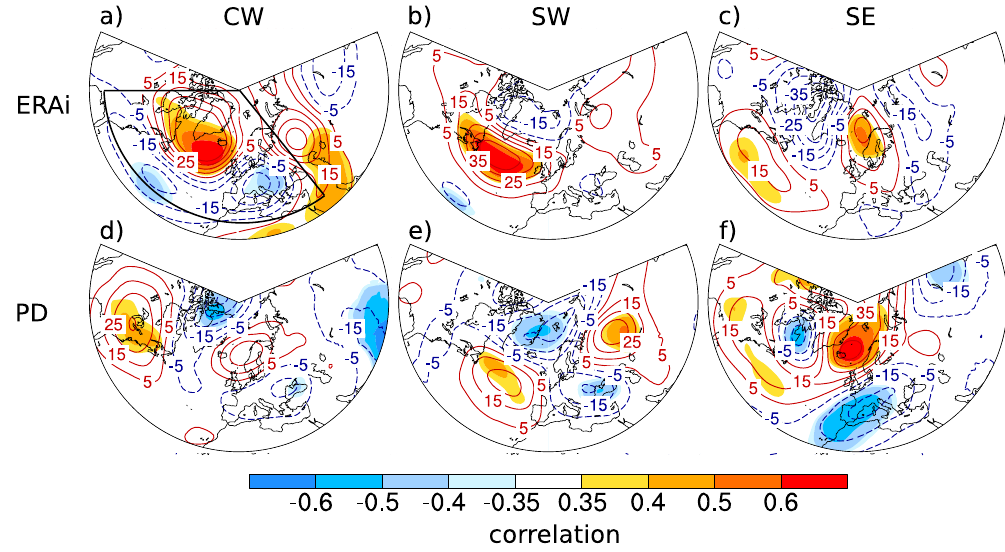
Fig. 7. z500 correlation and plus–minus composite patterns associated with annual mean accumulation in CW, SW, and SE for (a, b, c) ERAi and (d, e, f) the PD simulation. The shading illustrates the correlation pattern significant at the 5% level ( t -test statistics). Contour lines illustrate the z500 plus–minus composite pattern (in geopotential height meters). The plus–minus composite corresponds to the difference pattern of the ± 1 standard deviation samples of annual mean accumulation. The framed area in CW (a) indicates the North Atlantic domain used by the pattern correlation